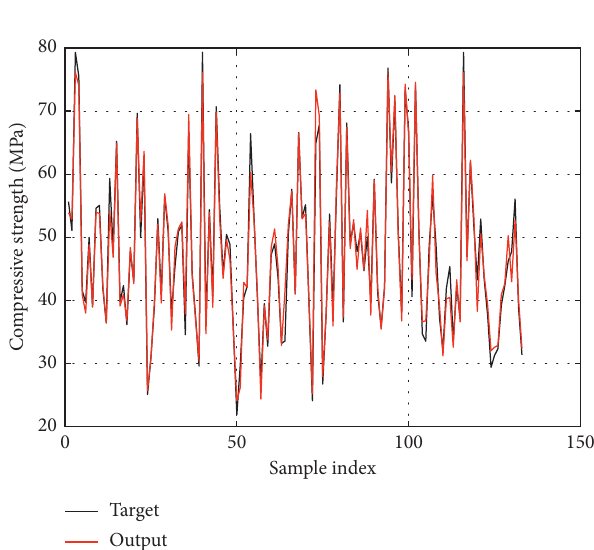
Figure 5: Prediction results of FNN for the training